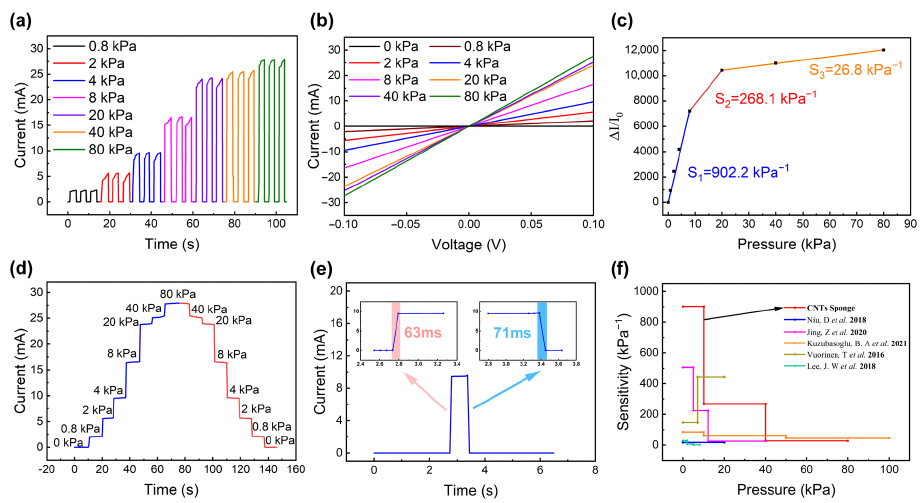
Figure 3. The pressure sensing properties of the CNT sponge: ( a ) the I-T curves at pressures less than 80 kPa; ( b ) the linear relationship of the I−V curves at voltages from −0.1 V to 0.1 V; ( c ) the sensitivity of the CNT sponge, reaching 902.2 kPa −1 below 10 kPa, 268.1 kPa −1 in the transitional pressure region (10 kPa to 20 kPa), and 26.8 kPa −1 in the high pressure region (20 kPa to 80 kPa); ( d ) gradient of the rise and fall of the current in the pressure region from 0 kPa to 80 kPa; ( e ) the response time of the CNT sponge for loading and unloading pressure; ( f ) the performance comparison with other pressure-sensitive materials [21−25].